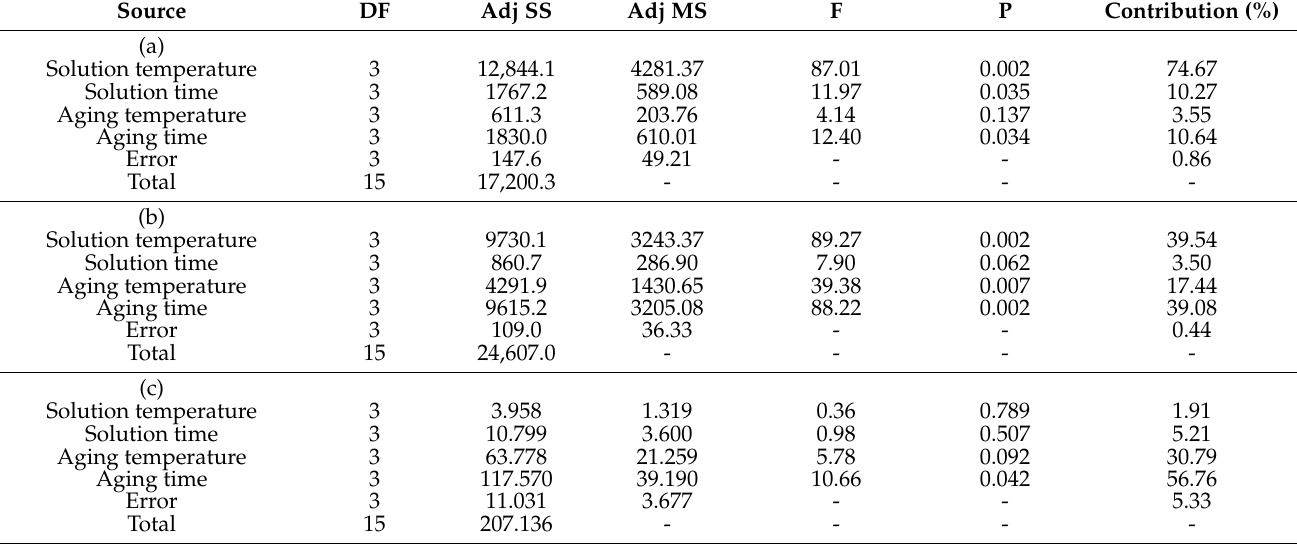
Table 4. Variance analysis of means for (a) UTS, (b) YS, and (c)